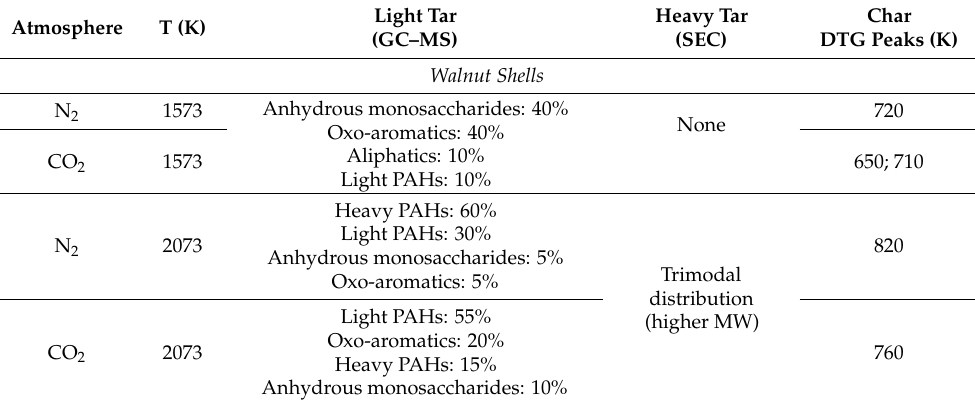
Table 3. Summary of results for walnut shells, pinewood and